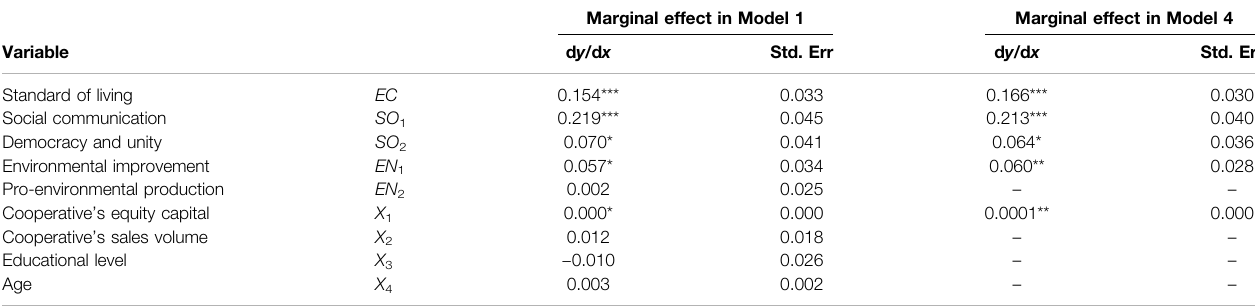
TABLE 3 | Average marginal effects of variables in logit Models 1 and 4 of member